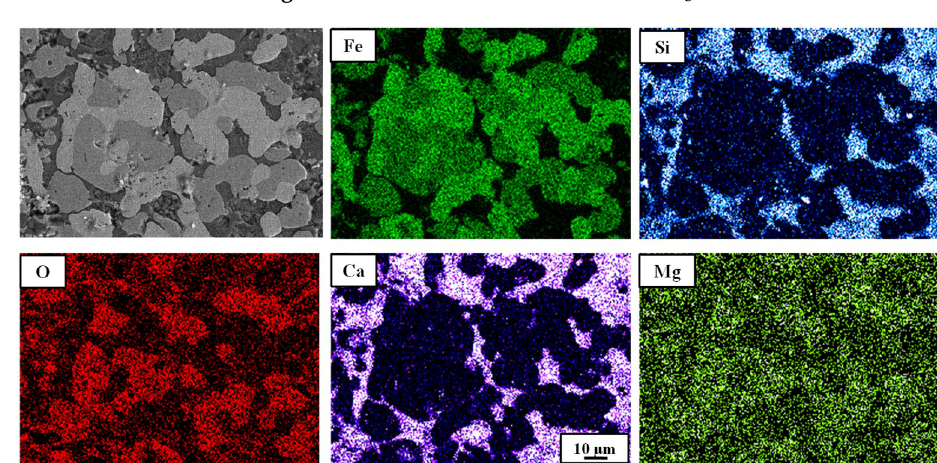
Figure 20. Element distributions of MPB at T S .